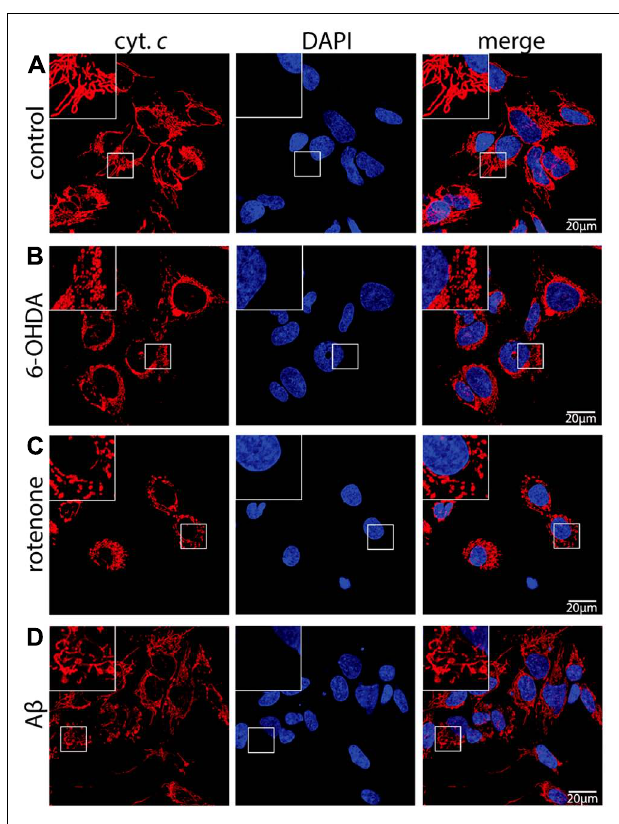
FIGURE 1 | Neurodegenerative stress causes mitochondrial fragmentation in neuronal cells . SH-SY5Y cells mock treated (control) (A) or exposed for 6 h to 75 μ M 6-hydroxydopamine (6-OHDA) (B) , for 6 h to 5 μ M rotenone (rotenone) (C) , or for 24 h to 25 μ M A β peptide (A β ) (D) were fixed and stained using anti-cytochrome c antibodies and DAPI to reveal mitochondrial morphology and the nucleus, respectively. Shown are representative pictures of at least three independent